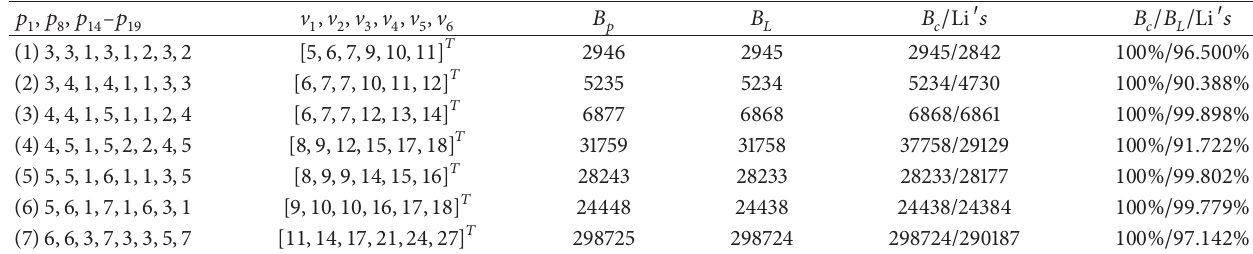
Table 2: Behavior permissiveness of the proposed deadlock prevention policy.